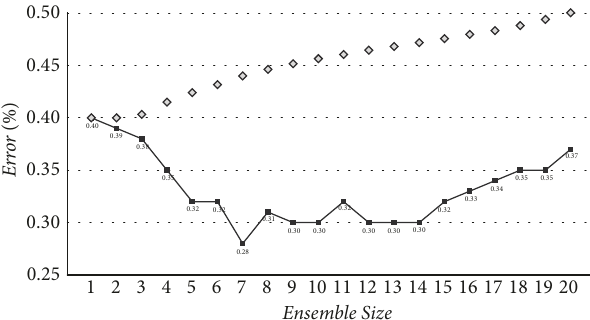
Figure 1: Error rateof CNNs committees with up to 20 models from GA with